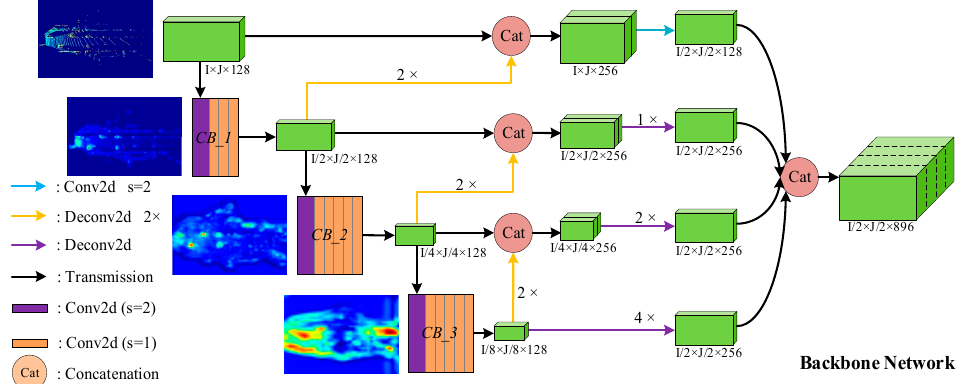
Figure 3. The architecture of Backbone Network. The meanings of lines and two-dimensional (2D) shapes with different colors in figure are given in the legend. Green 3D boxes represent feature maps with different sizes.